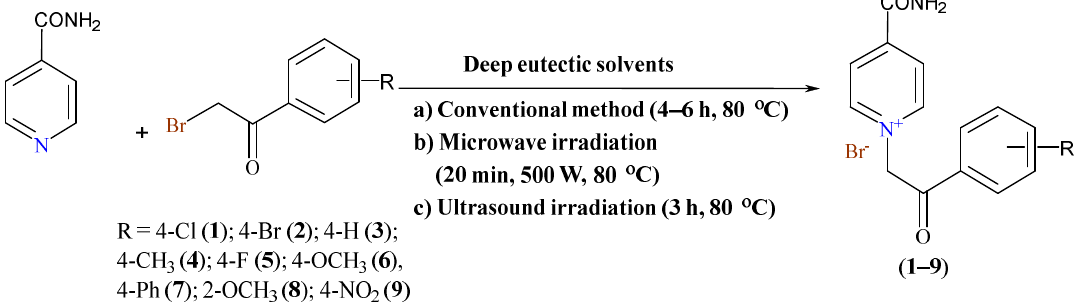
Figure 1. Synthesis of quaternary isonicotinamide salts from isonicotinamide and substituted phenacyl bromides in DESs.